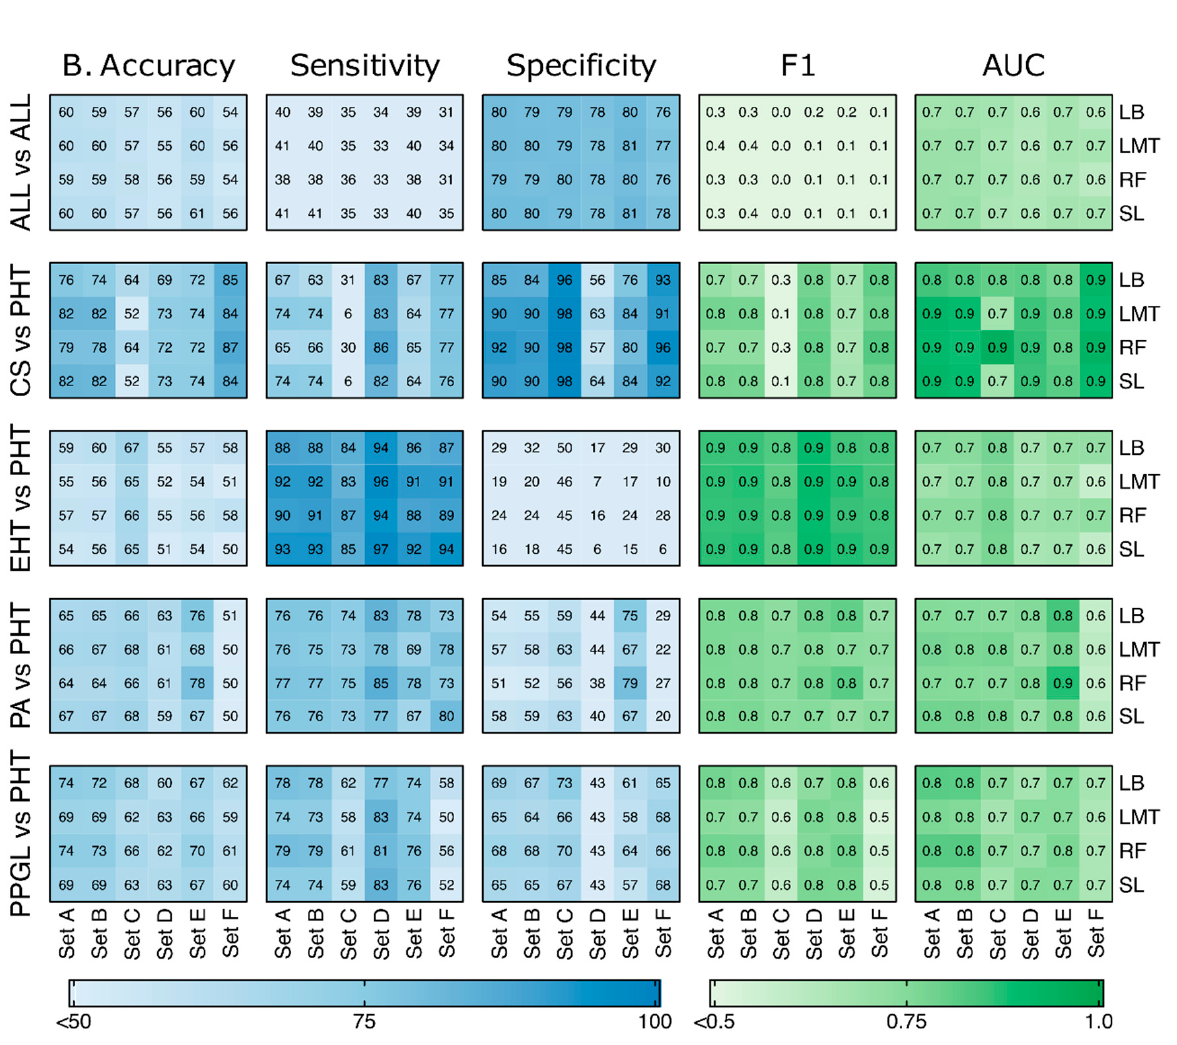
Figure 2. Heatmap comparing accuracy, sensitivity, and specificity for Sets A–F using 5 classifiers for 5 disease combinations (Phase 2). The count in each box is a weighted average of 100 runs (MCCV repeats).